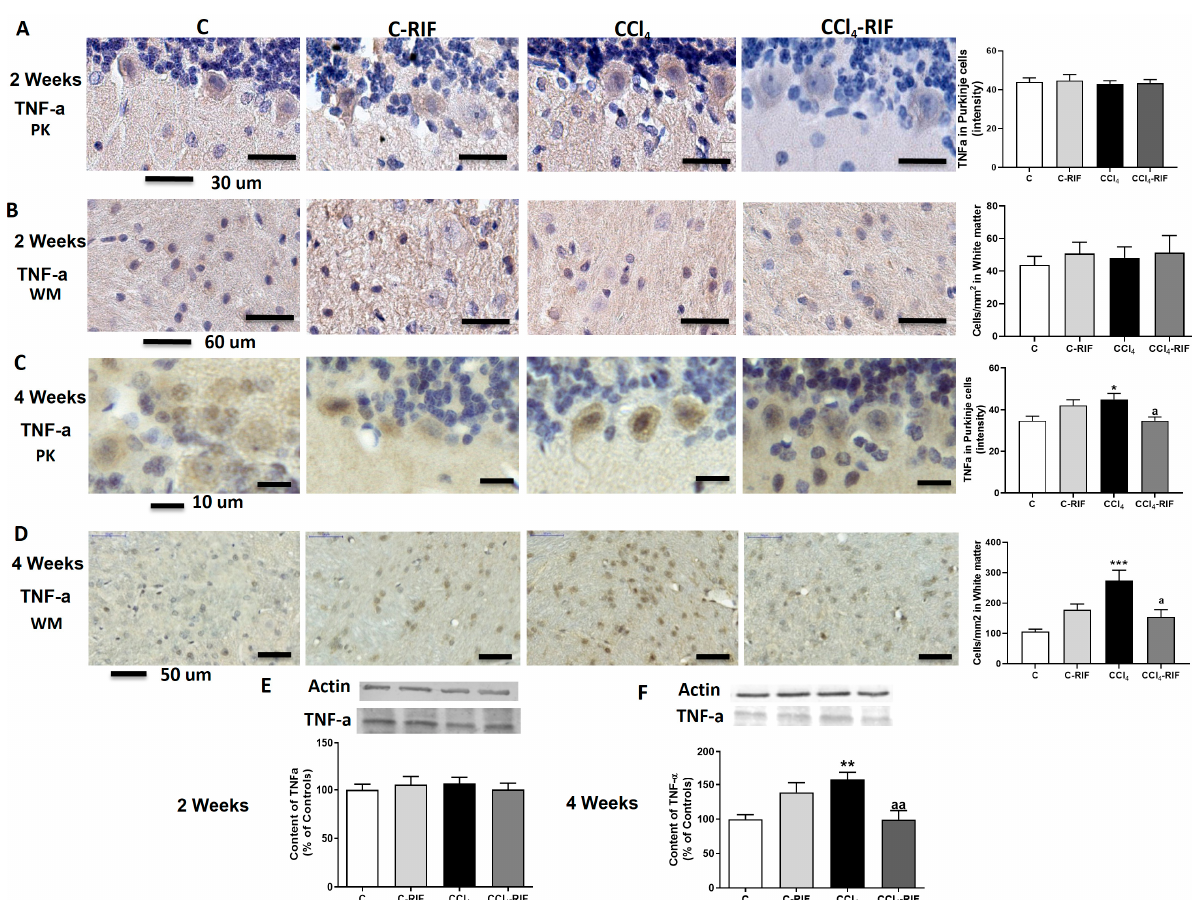
Figure 9. Expression of TNF- α in cerebellum of rats with liver damage. ( A , B ) Representative images and analysis of TNF- a expression in Purkinje neurons and white matter of cerebellum at 2 weeks. ( C , D ) Representative images and analysis of TNF- α expression in Purkinje neurons and white matter of cerebellum at 4 weeks. Values are mean ± SEM of 3–4 rats per group. Welch’s ANOVA test with Dunnett’s test for multiple comparisons was performed for Purkinje cells at 2 weeks (W(3,13) = 2.938, p < 0.05) and white matter at 4 weeks (W(3,10) = 11.03, p < 0.0001). Kruskal–Wallis with Dunn’s test was performed for white matter at 2 weeks (K-W(4,8) = 0.569, p > 0.05) and Purkinje cells at 4 weeks (K-W(4,5) = 12.02, p < 0.01). Content of TNF- α in cerebellum at ( E ) 2 and ( F ) 4 weeks was also quantified by Western blot. Values are mean ± SEM of 10–16 rats per group. One-way ANOVA with multiple comparisons with Tukey’s test was performed (F(3,15) = 5.927, p < 0.01 at 4 weeks; F(3,16) = 0.219, p > 0.05 at 2 weeks). Values significantly different from control rats are indicated by asterisks and from CCl 4 rats by a. * p < 0.05, ** p < 0.01, *** p < 0.001, a p < 0.05, aa p < 0.01.